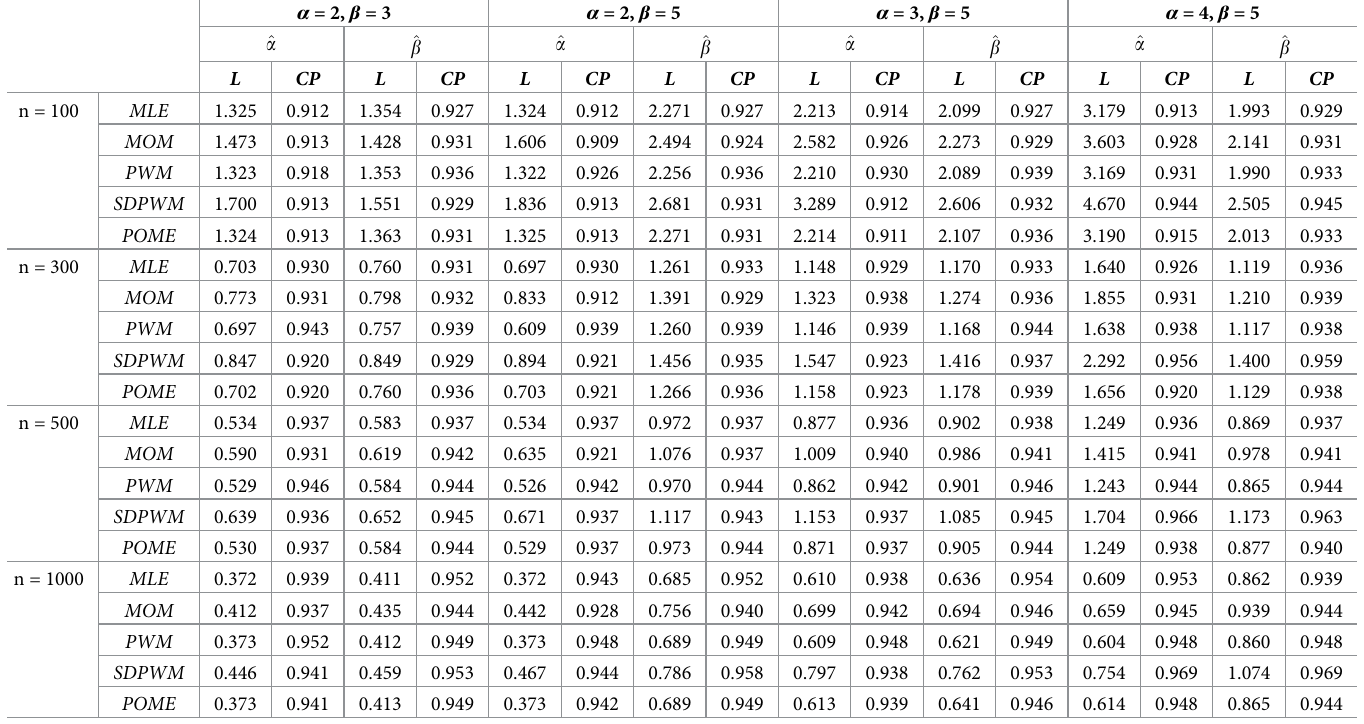
Table 9. The average length (L) and coverage probability (CP) of the bootstrap confidence intervals for α and β when α < β and for different choices of n . α = 2, β = 3 α = 2, β = 5